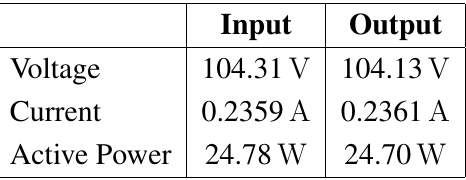
Table 2. Measured input and output voltage, current, and